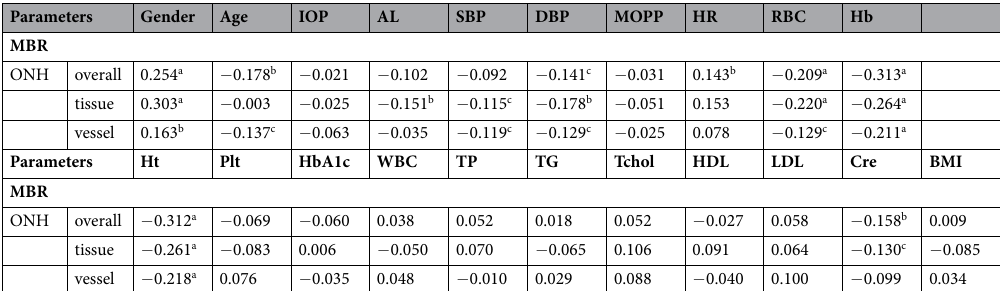
Table 2. Result of Spearman’s rank correlation coefficient between the MBRs and clinical parameters. MBR: mean blur rate; ONH: optic nerve head; IOP: intraocular pressure; AL: axial length; SBP: systolic blood pressure; DBP: diastolic blood pressure; MOPP: mean ocular perfusion pressure; HR: heart rate; RBC: retinal blood cell; Hb: hemoglobin; Ht: hematocrit; Plt: platelet; WBC: white blood cell; TP: total protein; TG: triglycerid; Chol: cholesterol; HDL: high-density lipoprotein; LDL: low- density lipoprotein; Cre: creatinine; BMI: Body mass index, a p < 0.001, b p < 0.01, c p <